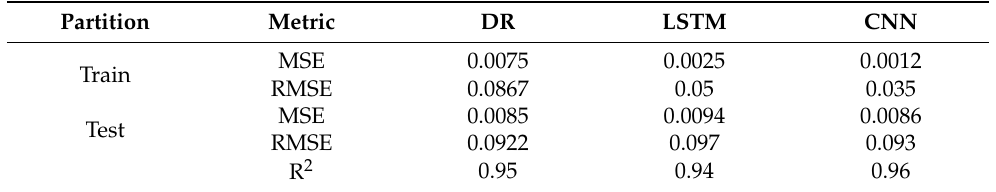
Table 4. Average error obtained with the last